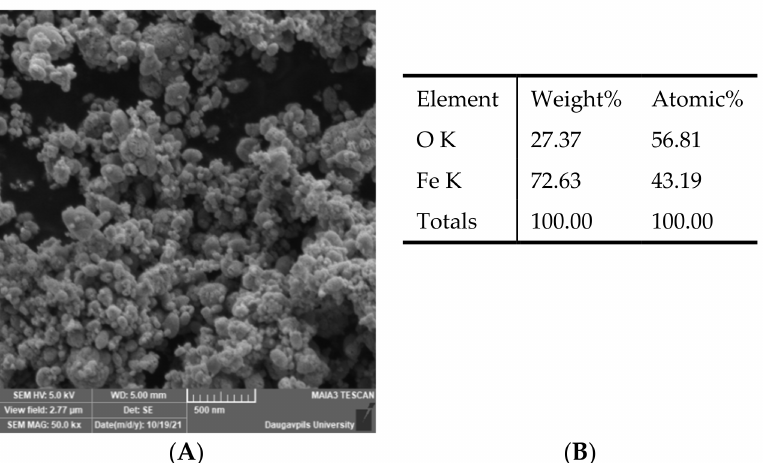
Figure 1. SEM image and chemical composition of Fe 3 O 4 nanoparticles. ( A )—SEM image of Fe 3 O 4 nanoparticles; ( B )—chemical composition of Fe 3 O 4